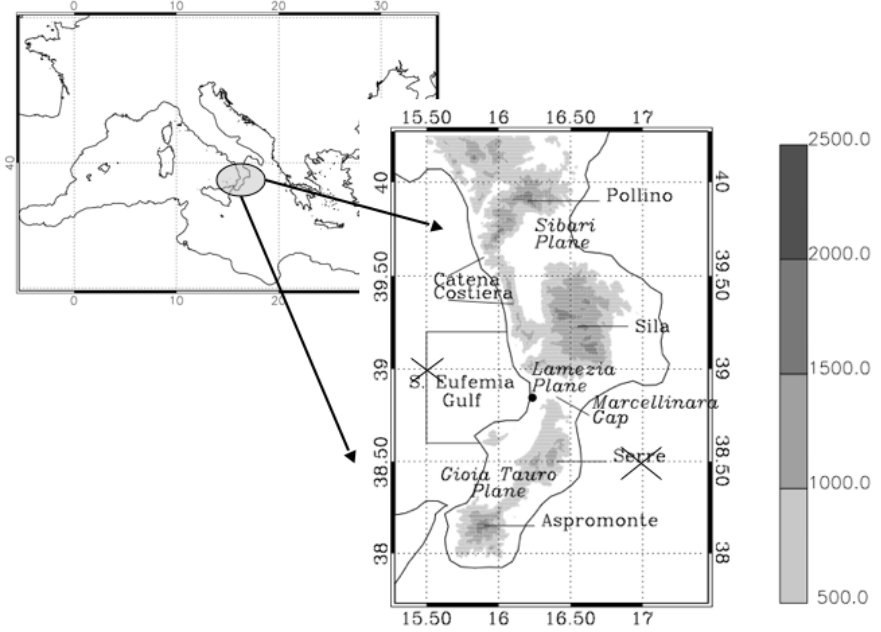
Figure 1. Calabria region in the central Mediterranean. Left: topography (m, gray shading) with topographical features cited into the text. The black dot shows the location of the experimental field. Crosses denote grid points considered in Table